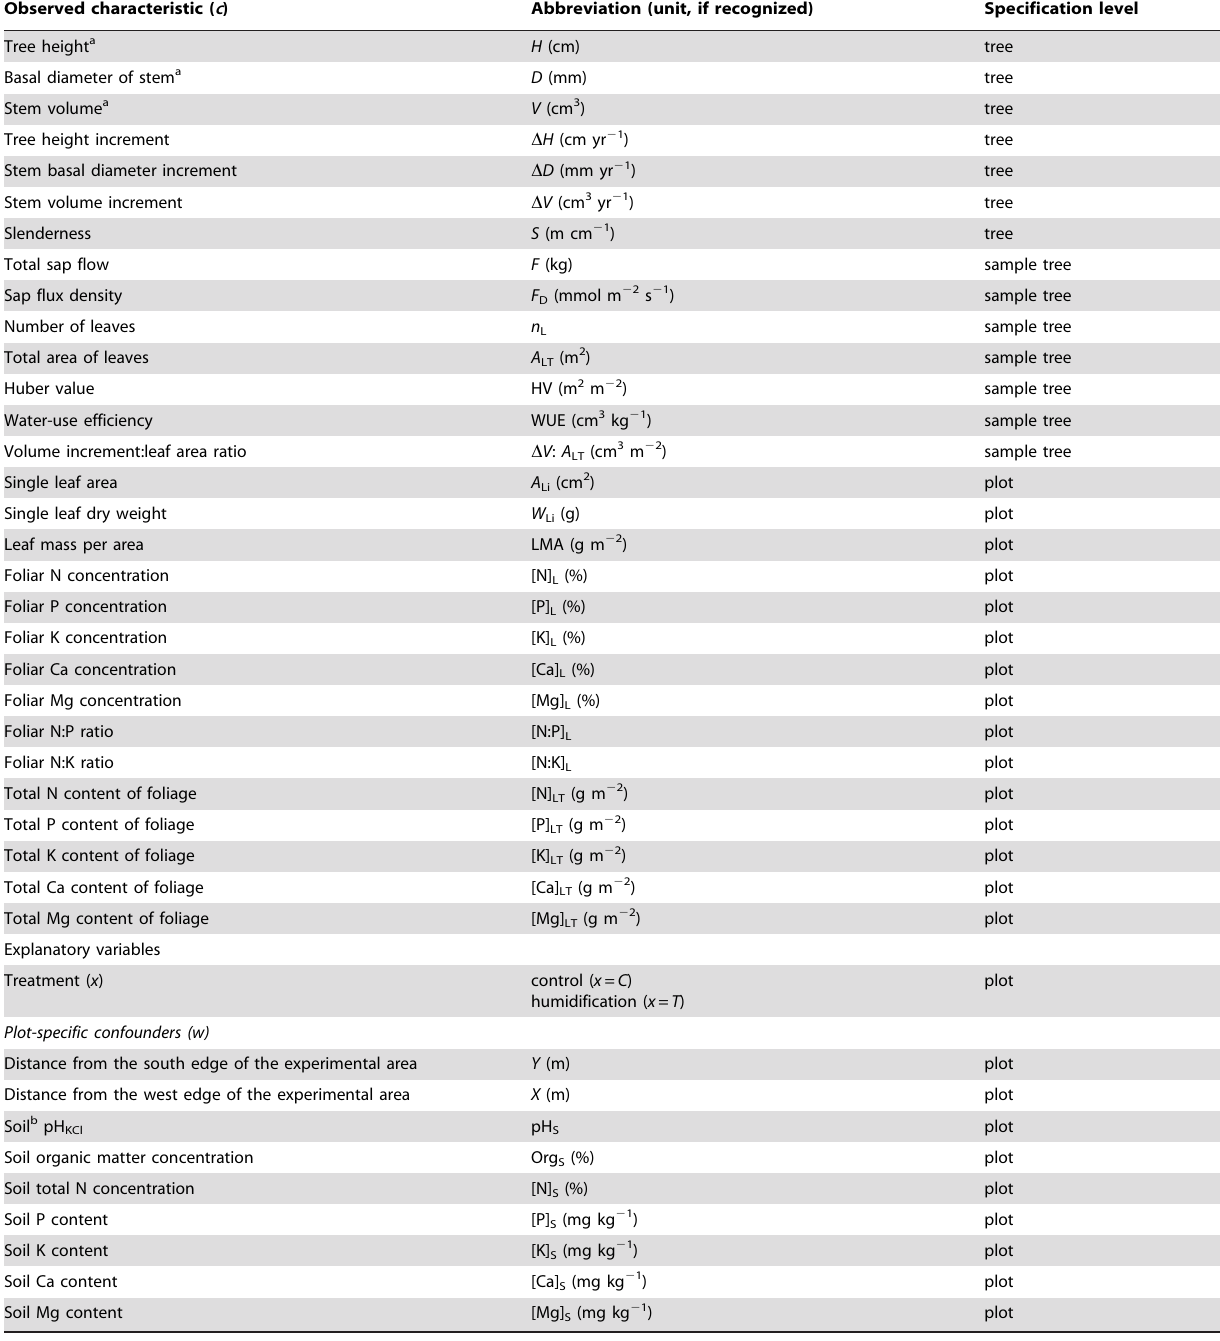
Table 3. Analysed